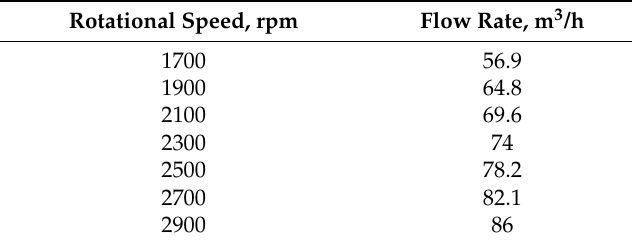
Table 3. Rotational speeds and corresponding flow